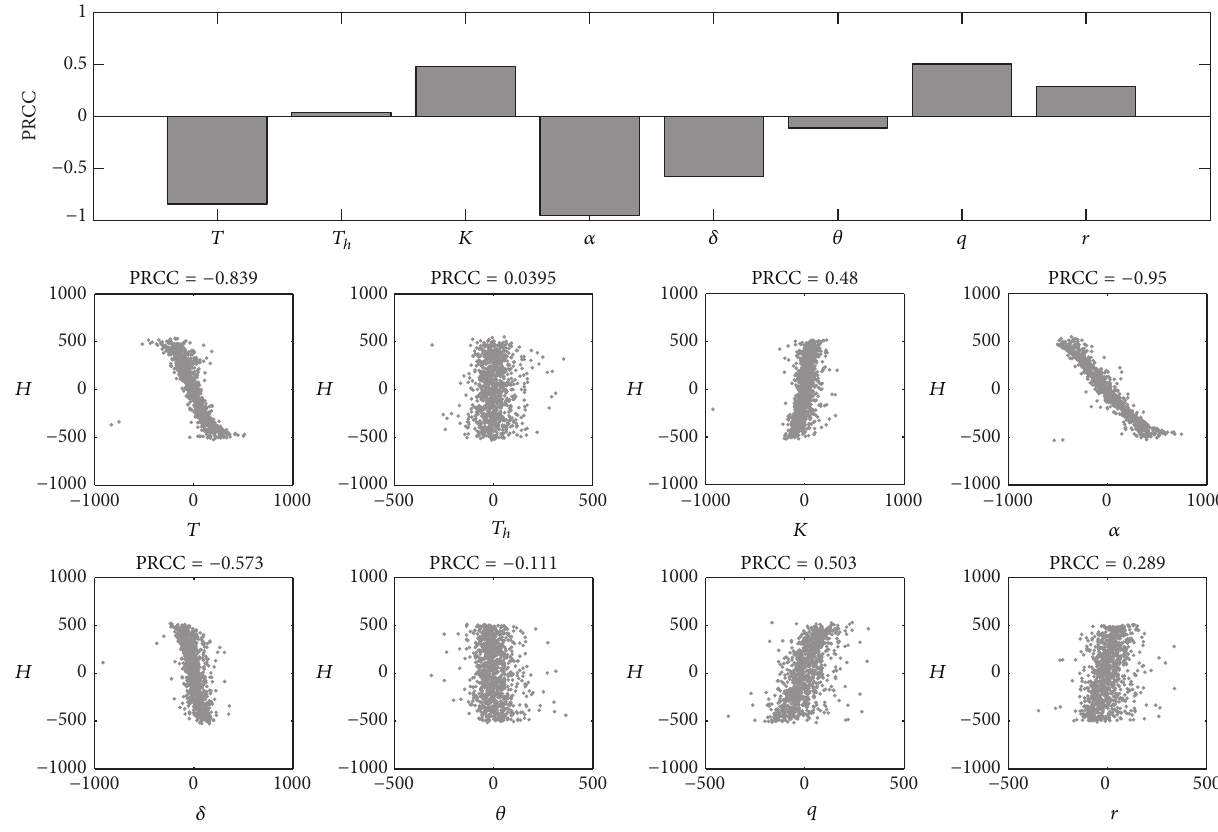
Figure 13: Sensitivity analyses based on the PRCC values for the host population at 1000th generation. The baseline parameter values are as follows: 𝑇 = 10 , 𝑇 ℎ = 0.5 , 𝐾 = 50 , 𝛼 = 0.005 , 𝛾 = 1 , 𝛿 = 0.5 , 𝜃 = 1 , 𝑞 = 0.2 , and 𝑟 = 2.8